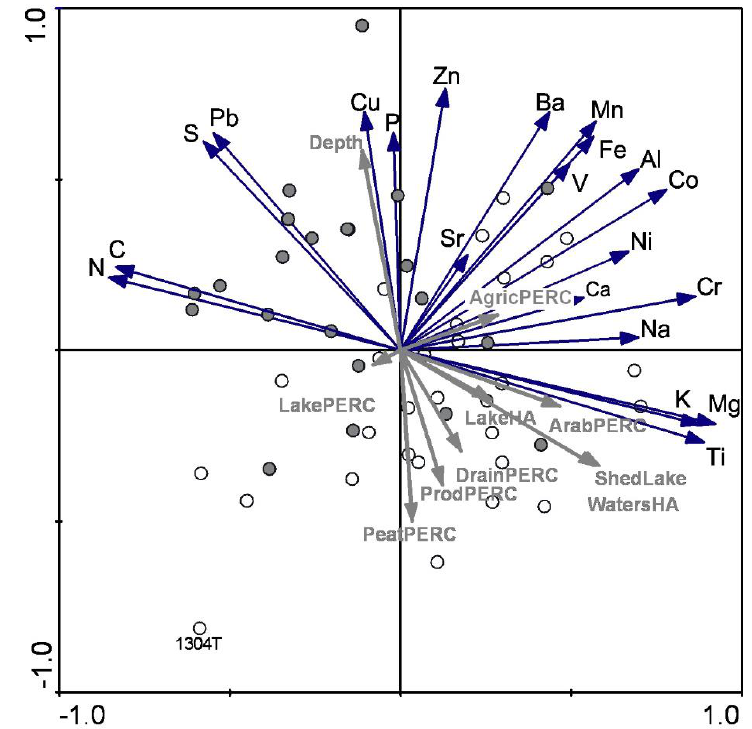
Figure 12. Sediment chemistry-based PCA plot of top (recent, human-impacted) samples, element concentrations, and environmental variables. Filled circles = reference lakes. concentrations, and environmental variables. Filled circles = reference